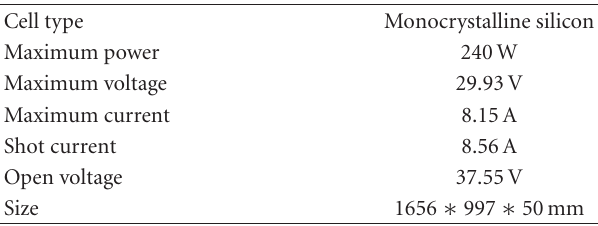
Table 1: PV module specifications.